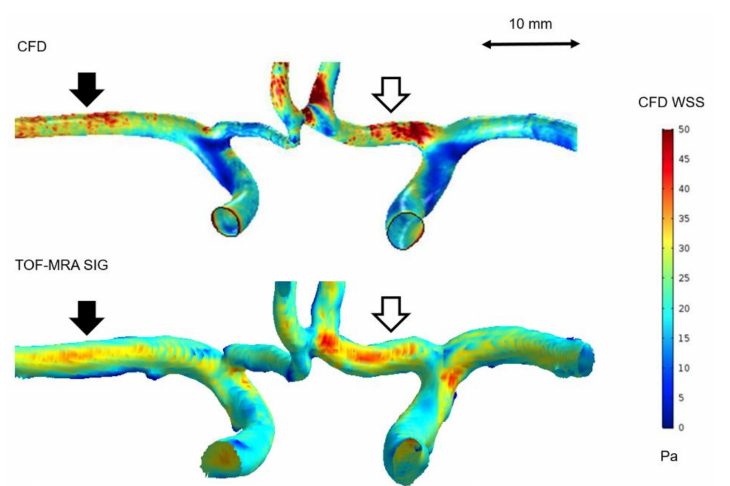
Figure 4. 3D wall shear stress (WSS) mapping derived from CFD and TOF-MRA SIG. A consistency was seen in the regions of high WSS at the right middle cerebral artery (MCA) M1 (black arrows) and left anterior cerebral artery (ACA) A1 (white